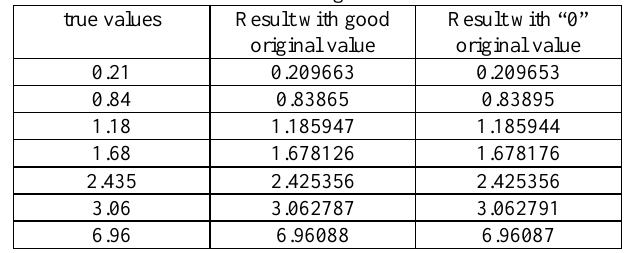
Table 4 ： comparation of results with differernt orginal